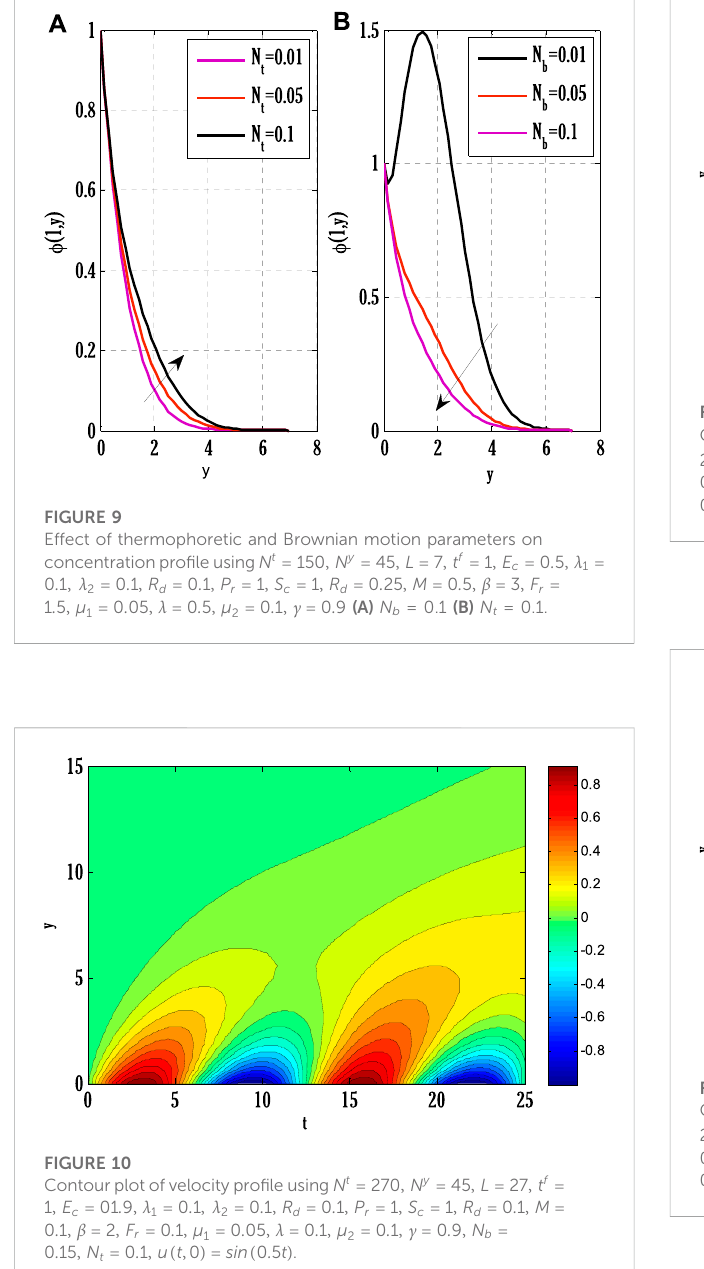
FIGURE 12 Contour plot of concentration pro fi le using N t (cid:2) 270 , N y (cid:2) 45 , L (cid:2) 27 , t f (cid:2) 1 , E c (cid:2) 01 . 9 , λ 1 (cid:2) 0 . 1 , λ 2 (cid:2) 0 . 1 , R d (cid:2) 0 . 1 , P r (cid:2) 1 , S c (cid:2) 1 , R d (cid:2) 0 . 1 , M (cid:2) 0 . 1 , β (cid:2) 2 , F r (cid:2) 0 . 1 , μ 1 (cid:2) 0 . 05 , λ (cid:2) 0 . 1 , μ 2 (cid:2) 0 . 1 , γ (cid:2) 0 . 9 , N b Velocity pro fi le rises by augmenting thermal and solutal mixed convection parameters. Theriseinthevelocitypro fi leresultsfrom thetemperatureand concentrationdifferencegrowthbetweenthewallandtheregionawayfrom the plate. Since the rise of temperature and concentration differences produces faster heat and concentration gradients in the fl ow, for mixed convection problems, temperature and concentration gradients are the factors responsible for generating fl ow in the fl uid. Therefore, the fl ow ’ s velocity develops by growing thermal and solutal mixed convection parameters. The effect of the Eckert number and radiation parameter on the temperature pro fi le is discussed in Figure 6. The rising Eckert number and radiation parameter boost the temperature pro fi le. Since the temperature pro fi le is affected by the dissipation due to internal friction of particles in the fl uid fl ow and by improving Eckert number, the temperature pro fi le escalates. Also, due to the entrance of radiations in the fl ow, heat fl ux increases; therefore, the temperature pro fi le is boosted.